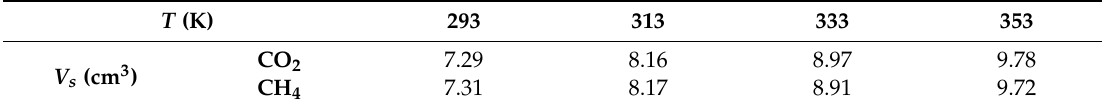
Table 2. The adsorption cell volume at experimental temperatures.